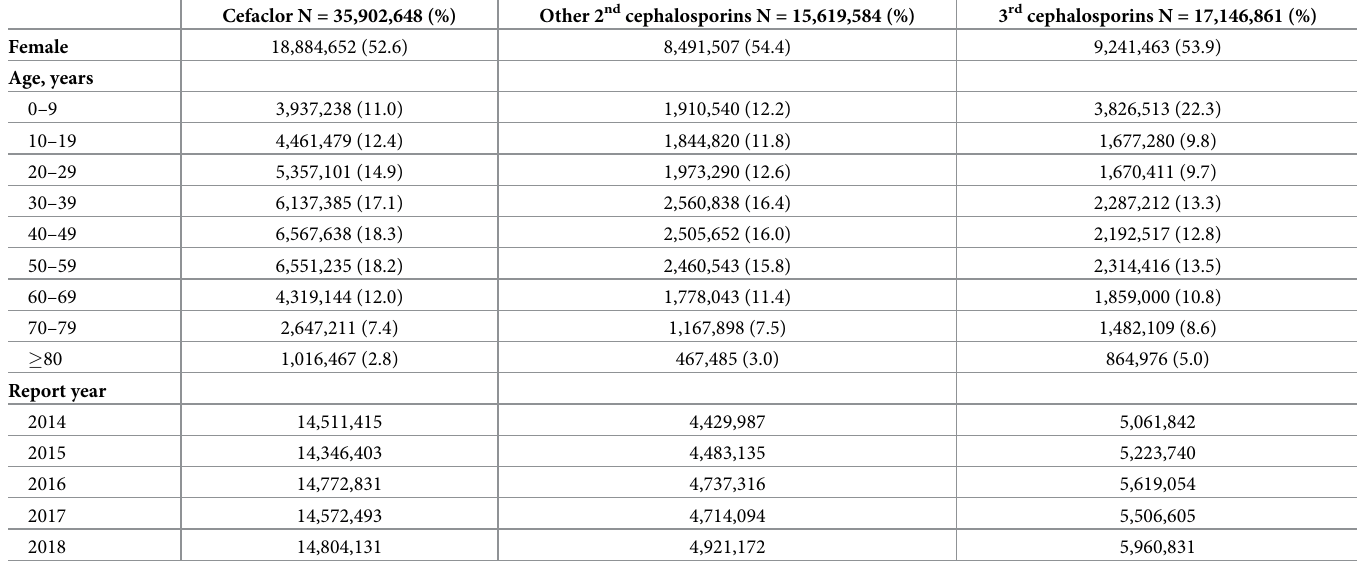
Table 1. Prescriptions of cefaclor and other 2 nd and 3 rd cephalosporins in the Health Insurance Review and Assessment Service database in Korea for the most recent 5 years. Cefaclor N = 35,902,648 (%) Other 2 nd cephalosporins N = 15,619,584